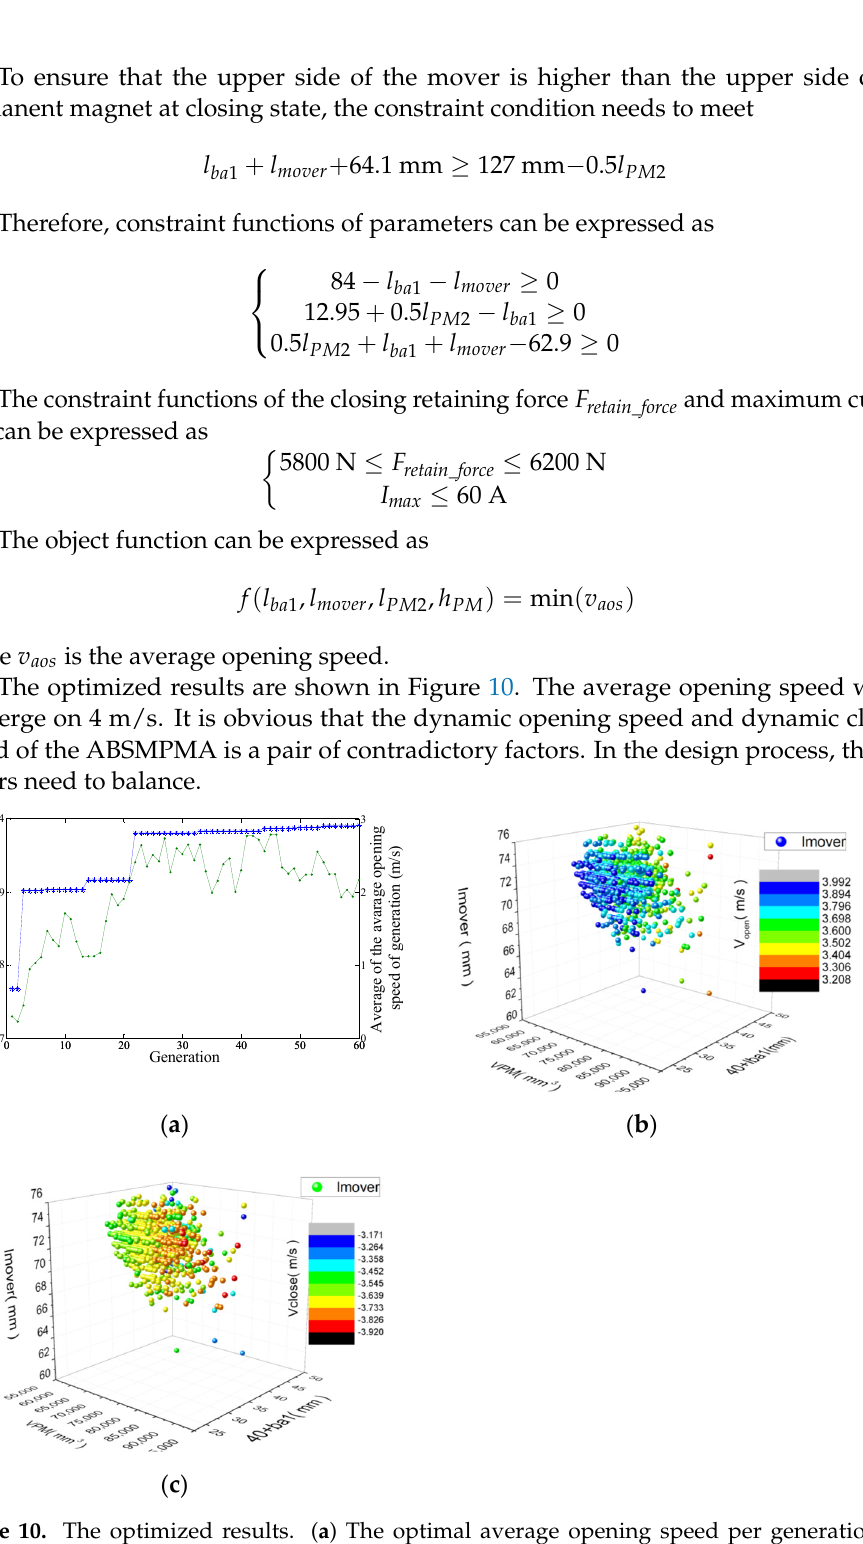
Figure 10. The optimized results. ( a ) The optimal average opening speed per generation and the average value of the average opening speed per generation. ( b ) The average opening speed characteristics within constraint conditions. ( c ) The average closing speed characteristics within constraint conditions.